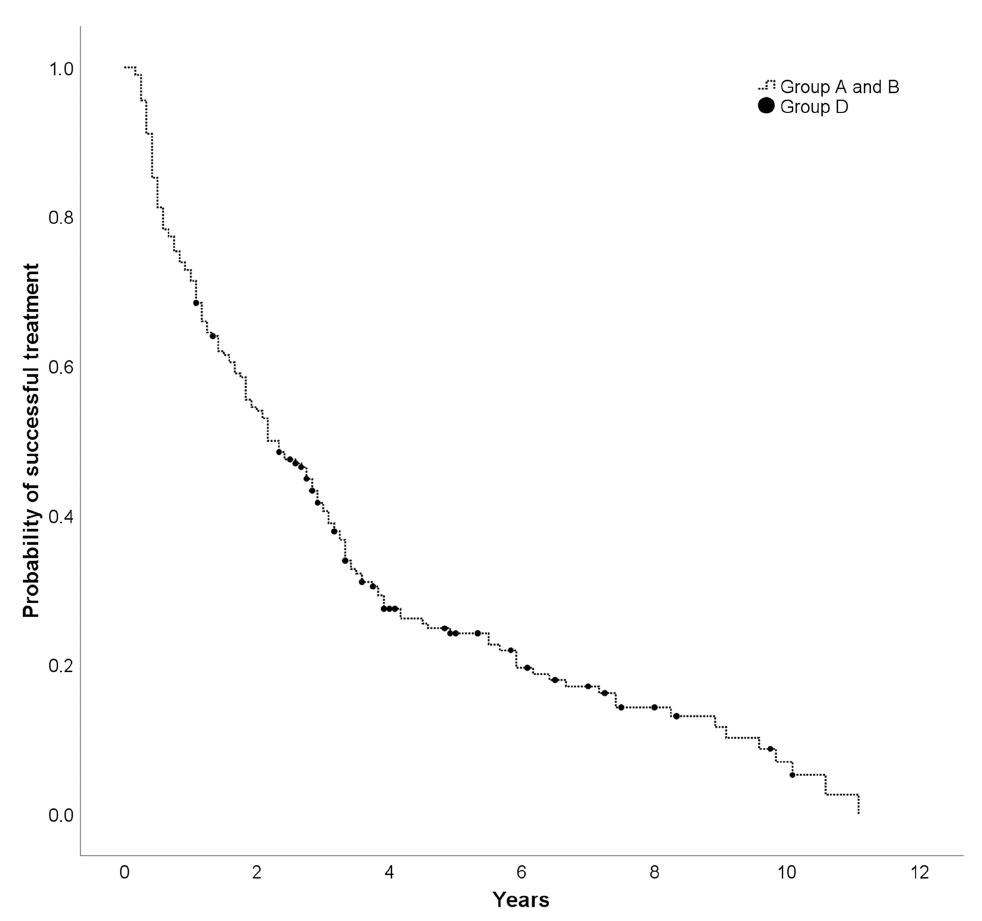
Figure 2. Successful therapy with bedtime NPH-insulin and metformin (Group A, B and